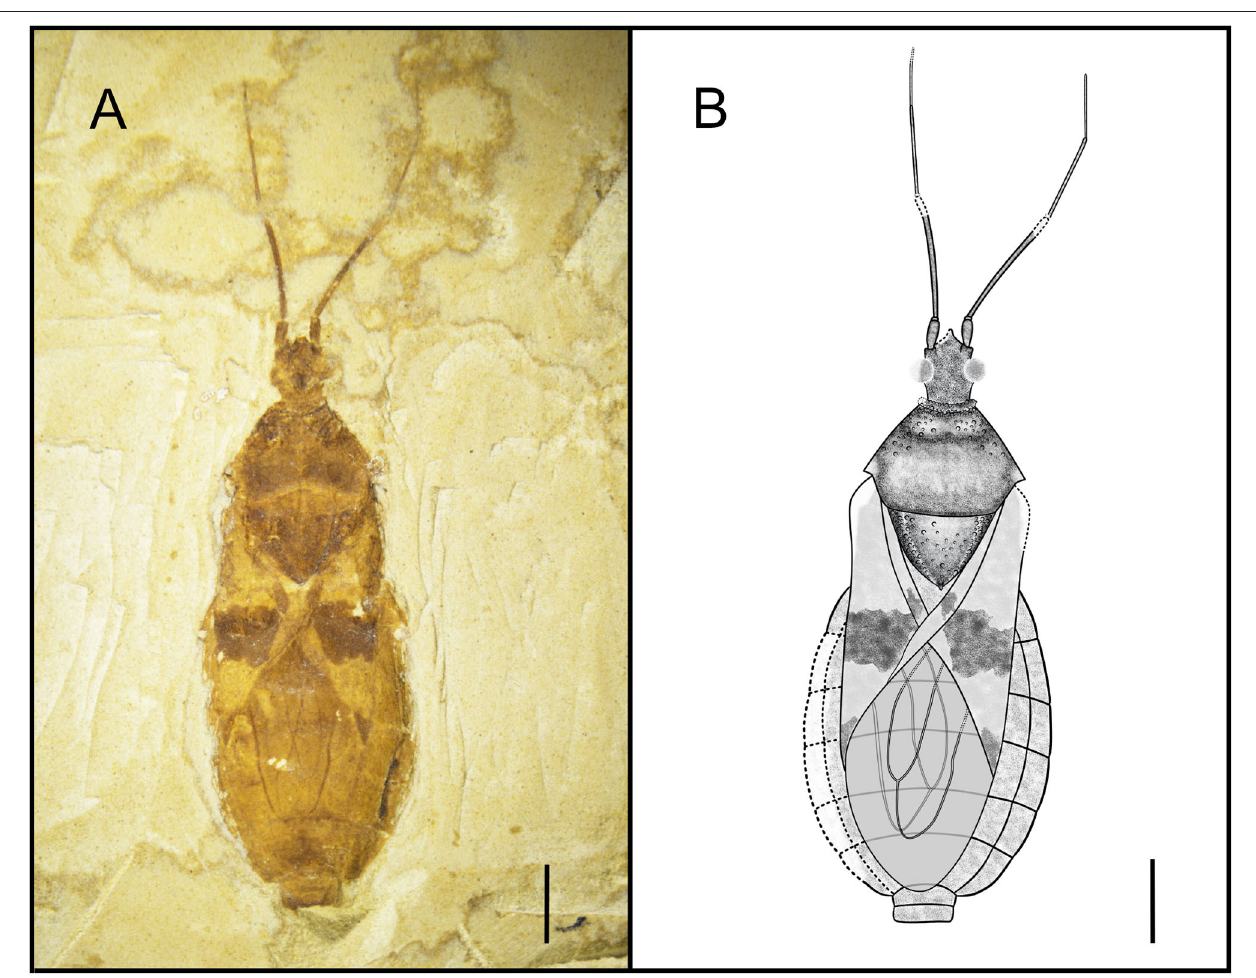
FIGURE 1 | Dorsal habitus of Simplicivenius tuberculosus gen. et sp. nov., holotype CNU-HET-LB2022001 (A) Photograph. (B) Line drawing. Scale bars = 2 mm.